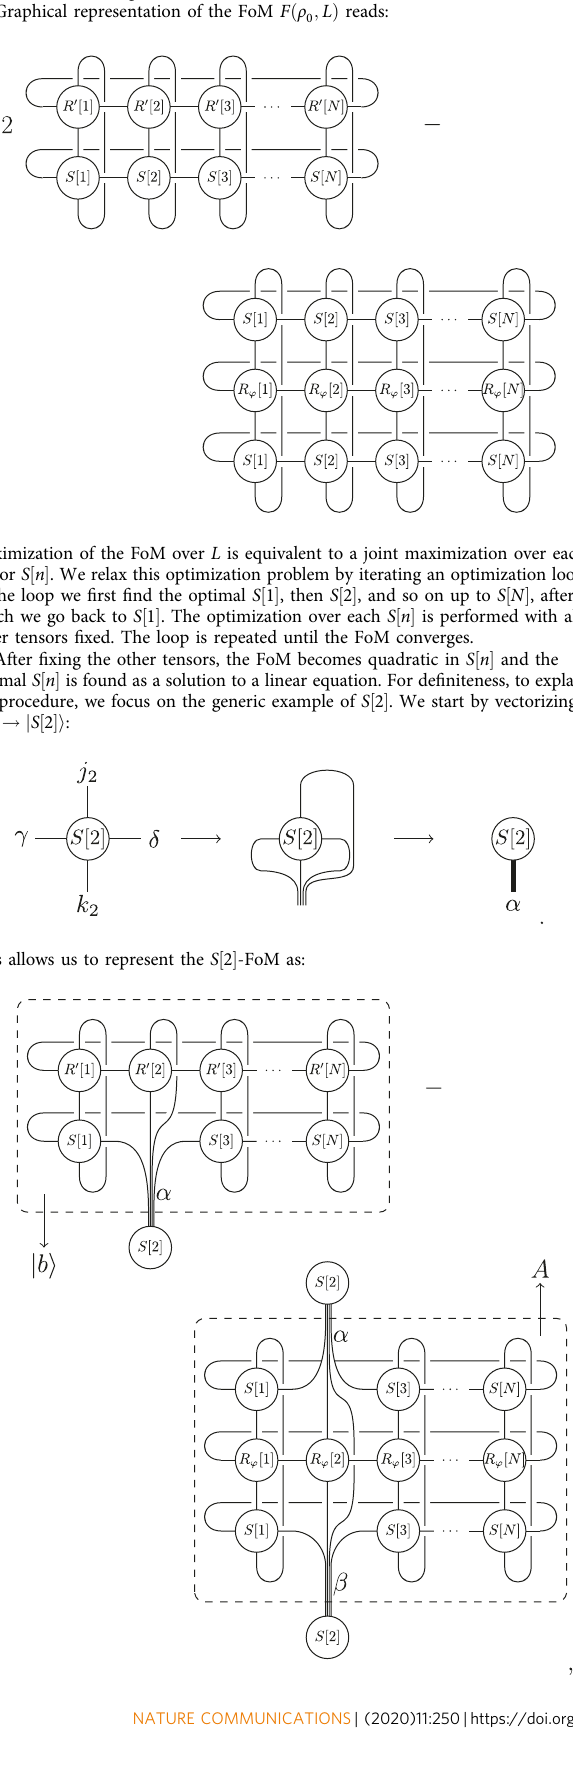
L ¼ 2 is the limiting value for uncorrelated noise models. Graphical representation of the FoM F ð ρ 0 ; L Þ reads: